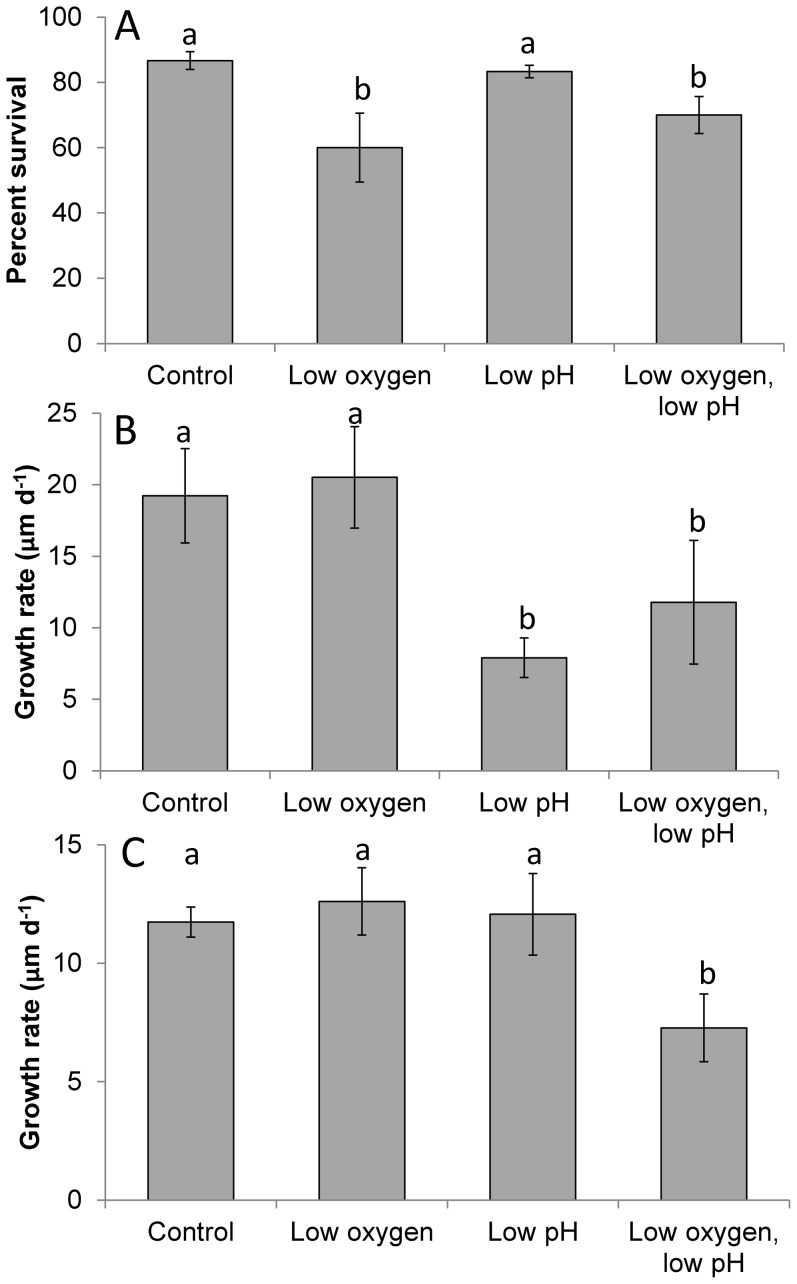
Performance of M. mercenaria exposure to two levels of pH and dissolved oxygen.
A. Percent survival of two month old individuals, B. Growth of two month old individuals, C. Growth of four month old individuals. Bars are means ±S.D. Dissolved oxygen and pH levels are presented in Figure 2. Complete carbonate chemistry appears in Tables S3 and S4, while statistical analyses appear in Tables S11, S12, and 13. Shared lower case letters indicate treatments that are not significantly different (p>0.05).